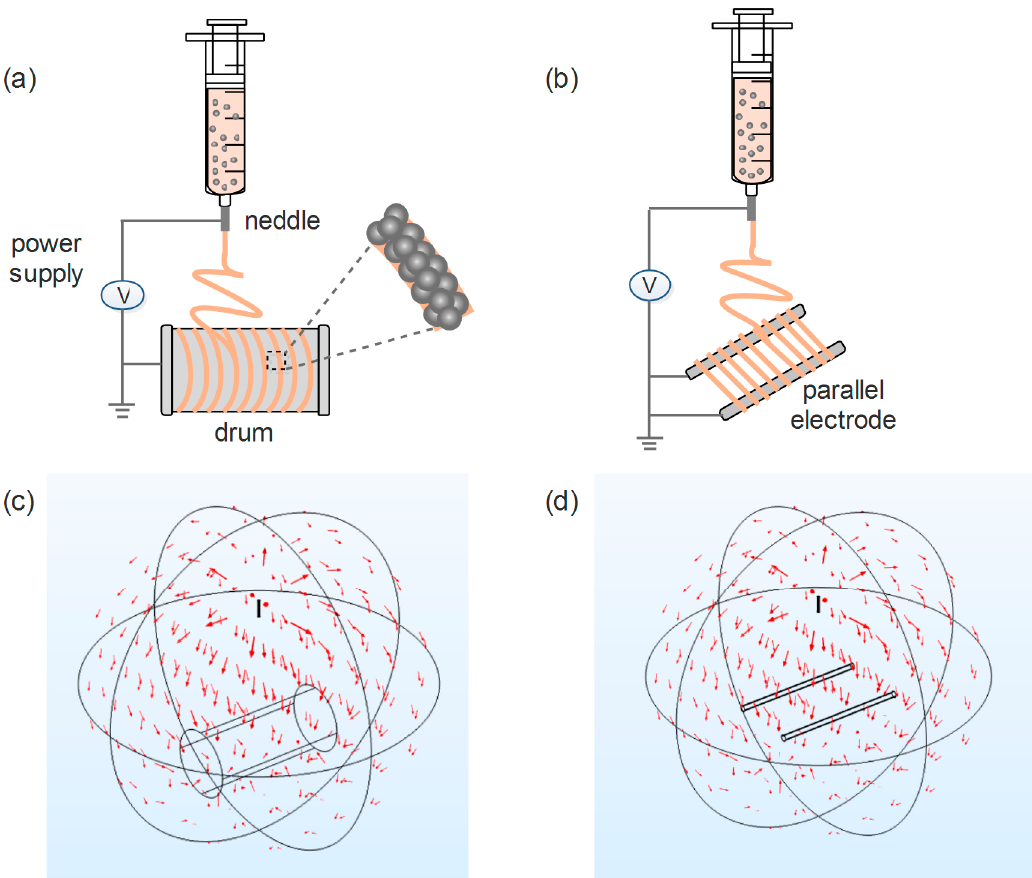
Figure 2. Schematic diagram of electrospinning setup using ( a ) rotating drum, ( b ) parallel electrode; representative simulation of electrostatic field distribution between the needle and ( c ) rotating drum, ( d ) parallel electrode using COMSOL software. Red arrows refer to electrostatic forces.